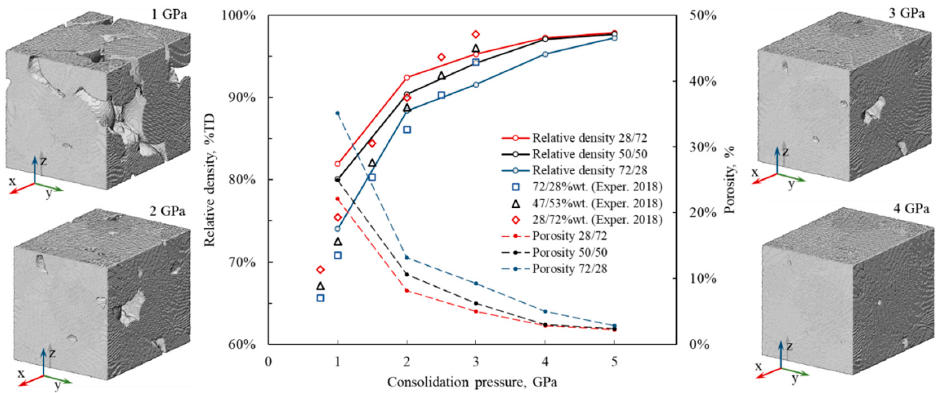
Figure 2. Calculated relative density (solid lines) and porosity (dashed lines) of cold-sintered Fe–Cu 28/72 (red), 50/50 (black), and 72/28 (blue) samples as a function of consolidation pressure. Experimental data points are shown by various symbols [42]. Four images of the model Fe–Cu 50/50 sample obtained at different consolidation pressures are included.